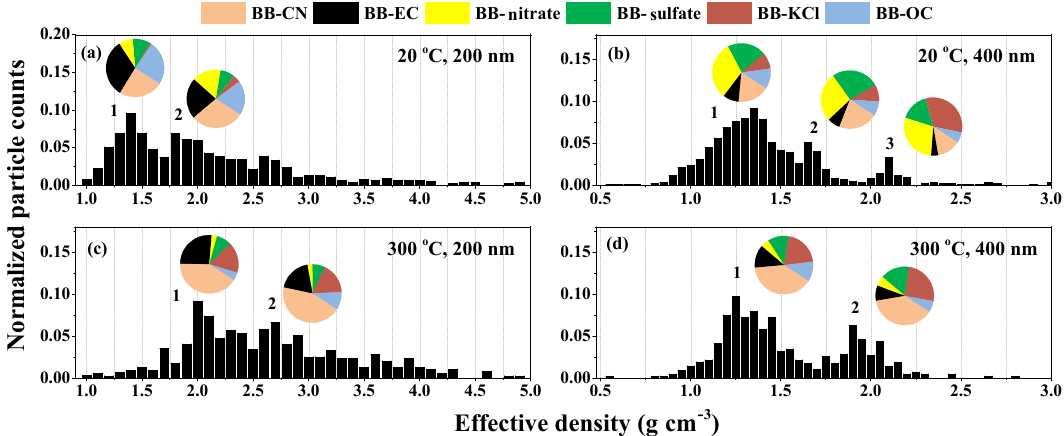
Figure 3. Vacuum aerodynamic size distributions detected by the SPAMS of 200 and 400nm electrical-mobility-selected biomass burning particles, and pie charts for the particle types in different aerodynamic modes at 20 ◦ C (room temperature) and 300 ◦